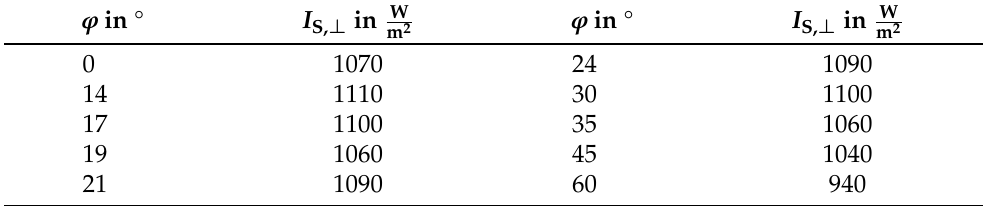
) for SATIS in state ⊥